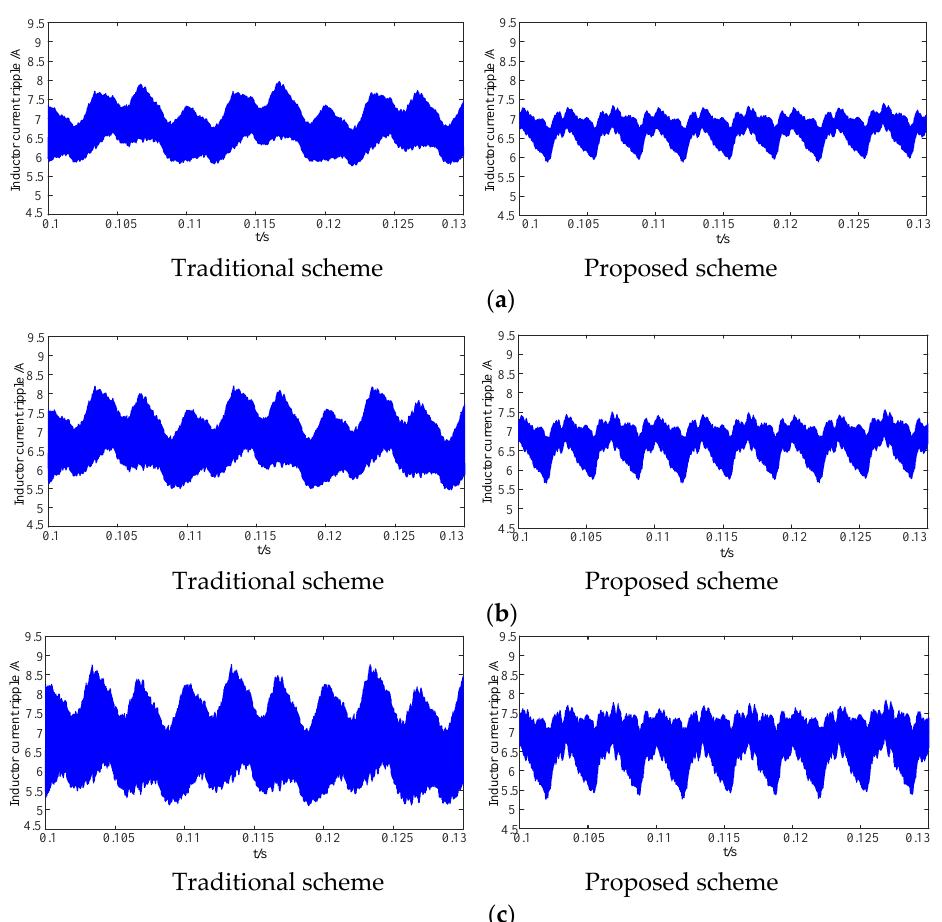
Figure 12. DC output filter inductor current waveform. ( a ) Inductance with 2 mH ( b ) Inductance with 1.5 mH ( c ) Inductance with 1 mH